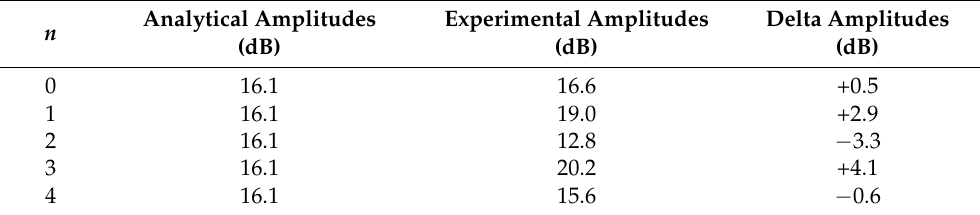
Table 4. Comparison between analytical and experimental TL amplitudes of simple expansion chamber.